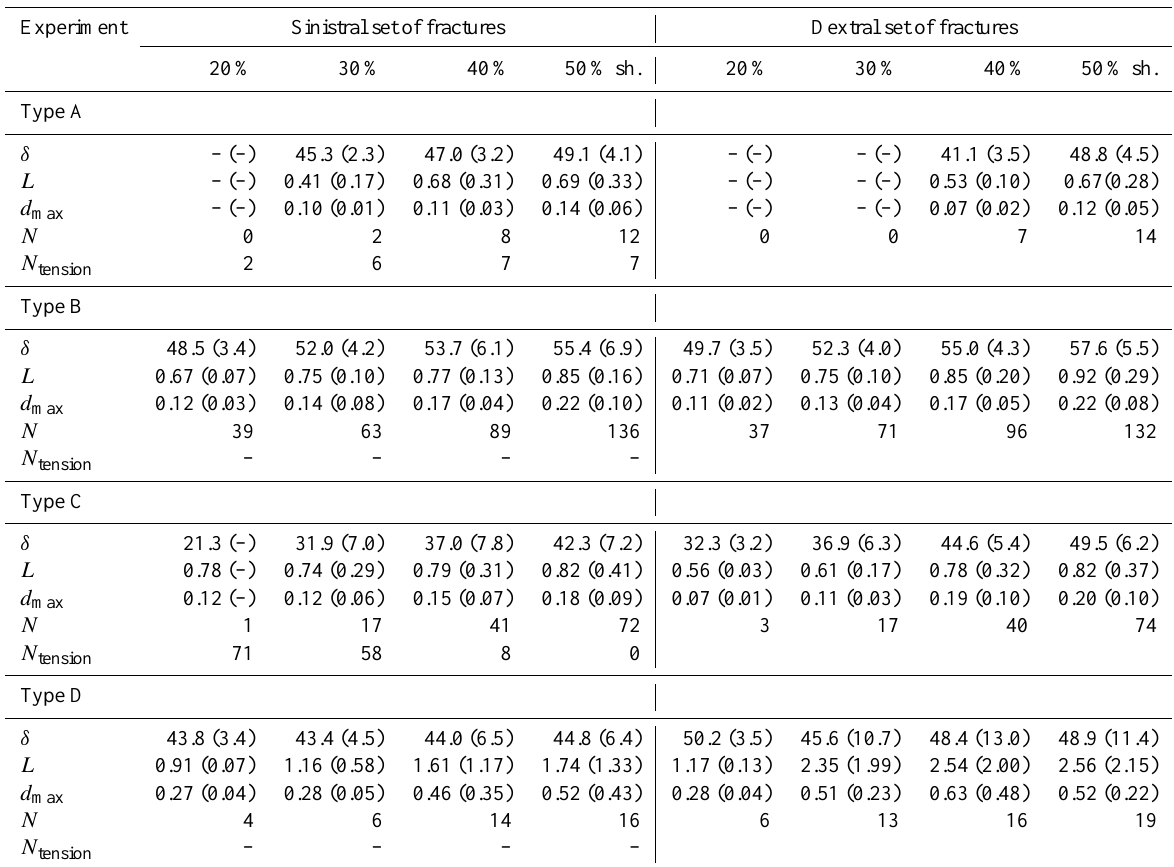
Table 4. Compilation of shear-fracture data at shortening intervals of 20, 30, 40 and 50%. δ is the average shear-fracture orientation with respect to the Z axis, measured in degrees. Fracture length ( L) and maximum displacement ( d max ) of shear fractures are measured in cm. Standard deviations are in parentheses. N and N tension indicate the total number of shear fractures and tension cracks respectively. Length ( L) values do not include data from tension cracks and refer to individual fracture segments. Fault zones composed of several segments are therefore longer than individual ones. The number of tension cracks for models B and D is not displayed, since cracks were too small to trace them accurately. Note that data corresponding to 50% shortening in model D were actually measured at 44% shortening, when this experiment